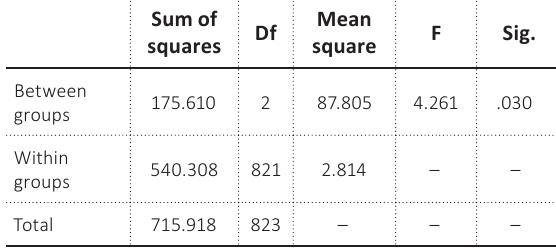
Table 3. ANOVA test for H3